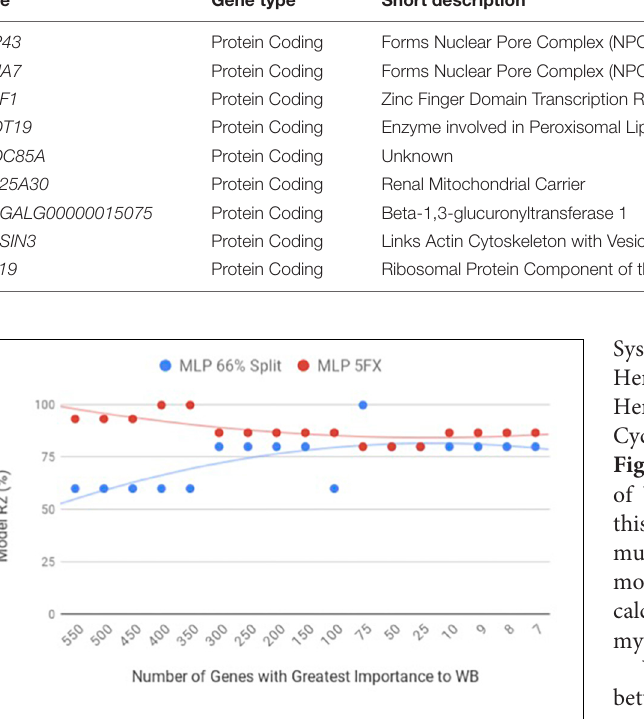
liver transcriptome dataset and CCDC85A and KPNA7 from the PM dataset ( Tables 2 , 3 ).